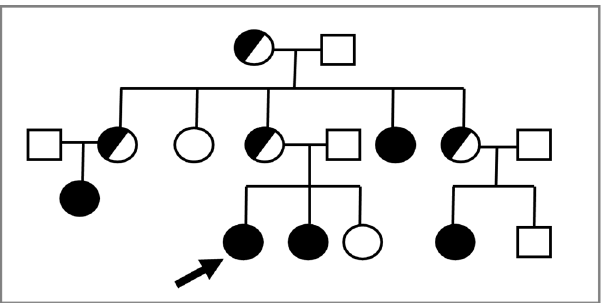
Figure 1. The proband (indicated by the arrow) is a young 46,XY woman (25 years old) with CAIS, in whom the AR variant p.Trp797* was found. Subsequently, the same mutation was detected in the 46,XY sister with CAIS ( ) and in other affected 46,XY family members with the same DSD ( ). Female 46,XX carriers were suspected but not proven by molecular analysis of AR .